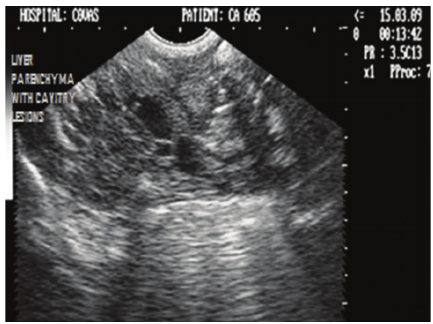
Figure 33: Sagittal sonograph (2D) of liver with extensive noncystic cavitary lesions in hepatic parenchyma in a nine-year-old intact male Boxer dog.